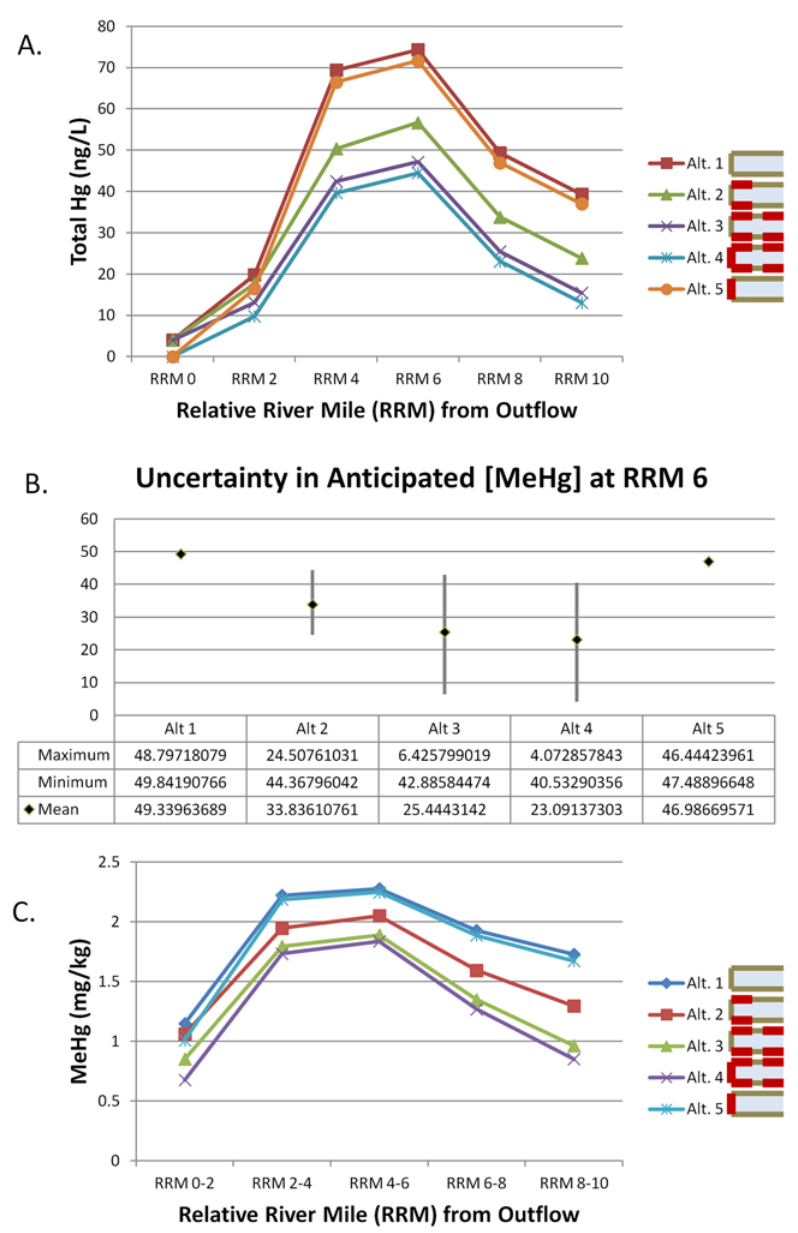
Figure 4. THg concentration predictions from the mass-balance model for the initial alternatives. (A.) The mean predicted water column concentrations in ng/L are reported for each alternative for each reach of the river as calculated by the mass balance model. Alternatives 1 and 5 result in higher predicted THg concentrations then the other alternatives along the length of the river. (B.) The uncertainty in anticipated water column THg concentration at relative river mile 6 is shown as predicted by the mass balance model. Below the graphical display are the calculated values for the maximum, minimum and mean concentration of THg (ng/L). Alternatives 1 and 5 are anticipated to result in higher mercury levels in this stretch of the river. The other alternatives cannot be distinguished because of the uncertainty in the loading multiplied by the anticipated rate of reduction. (C.) The mean predicted concentrations of MeHg in smallmouth bass tissue (mg/kg) are reported for each alternative in each river reach as calculated by the mass balance model. Following from the water concentrations, Alternatives 1 and 5 result in higher fish tissue concentrations than the other